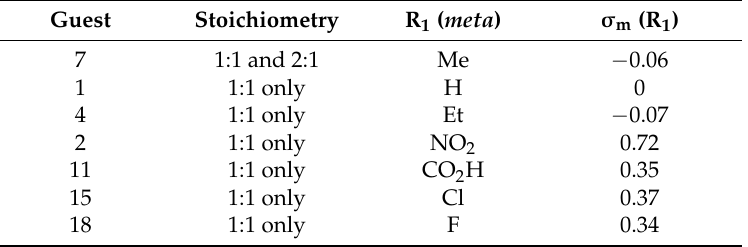
Table 5. Comparison of meta -substituted 2-[(R-Phenyl)amine]-1,4-naphthalenediones which form 2:1 and 1:1 vs. only 1:1 complexes with γ -CD.